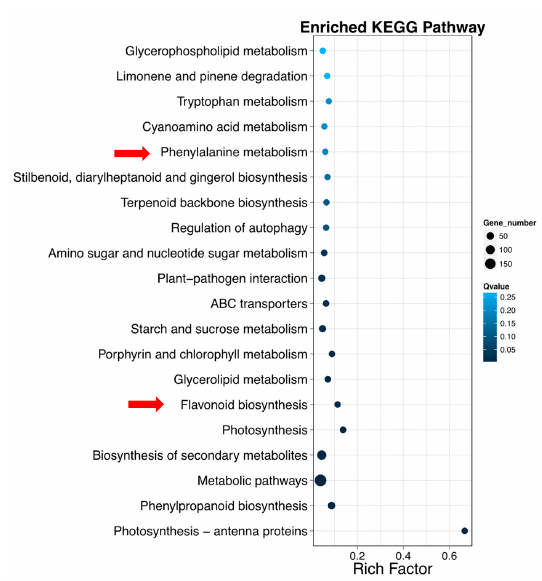
Figure 3. The most enrichment pathway of DEGs (TOP20). X axis: enrichment factor; Y axis: pathway name; The color: the q-value (high: white, low: blue), the lower q-value indicates the more significant enrichment; Point size: DEG number (The bigger dots refer to larger amount); Rich Factor: the value of enrichment factor, which is the quotient of foreground value (the number of DEGs) and background value (total Gene amount), the larger the value, the more significant enrichment. Red arrows represent the pathways related directly to the anthocyanin